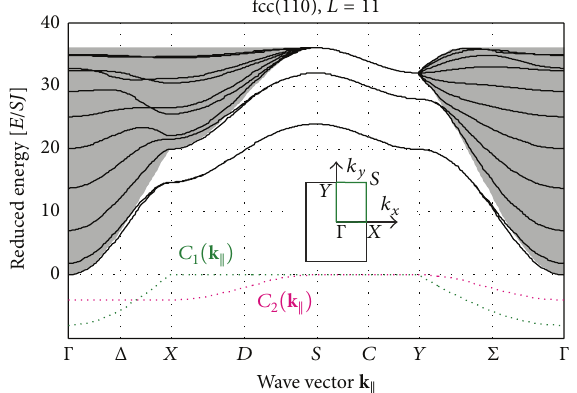
Figure 9: Spin-wave spectrum of an 11-layer thick fcc(110) thin film for 𝐽 𝑁 /𝐽 = 0.5 , that is, the special case for which the bulk band collapse occurs even for NNN interactions switched on. Solid lines represent the energy of individual modes; the shaded area is the bulk band for in-plane spin waves. The spectrum is plotted along the high-symmetry path shown in (a), inset, and accompanied with the evolution of off-diagonal elements of the Hamiltonian matrix 𝐶 1 (green dotted line) and 𝐶 2 (purple dotted line).